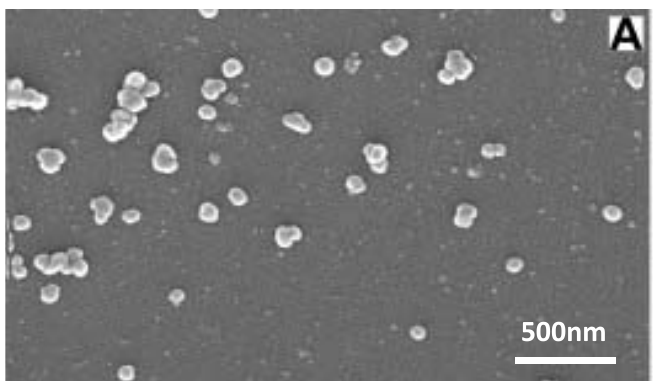
Figure 9. SEM of spherical bioactive glass nanoparticles with the formulation SiO:P O :CaO = 55:40:5 (mol). This demonstrates the homogeneity of the nanoparticles 2 5 and also the aggregation characteristics. Reproduced from [32] with permission from